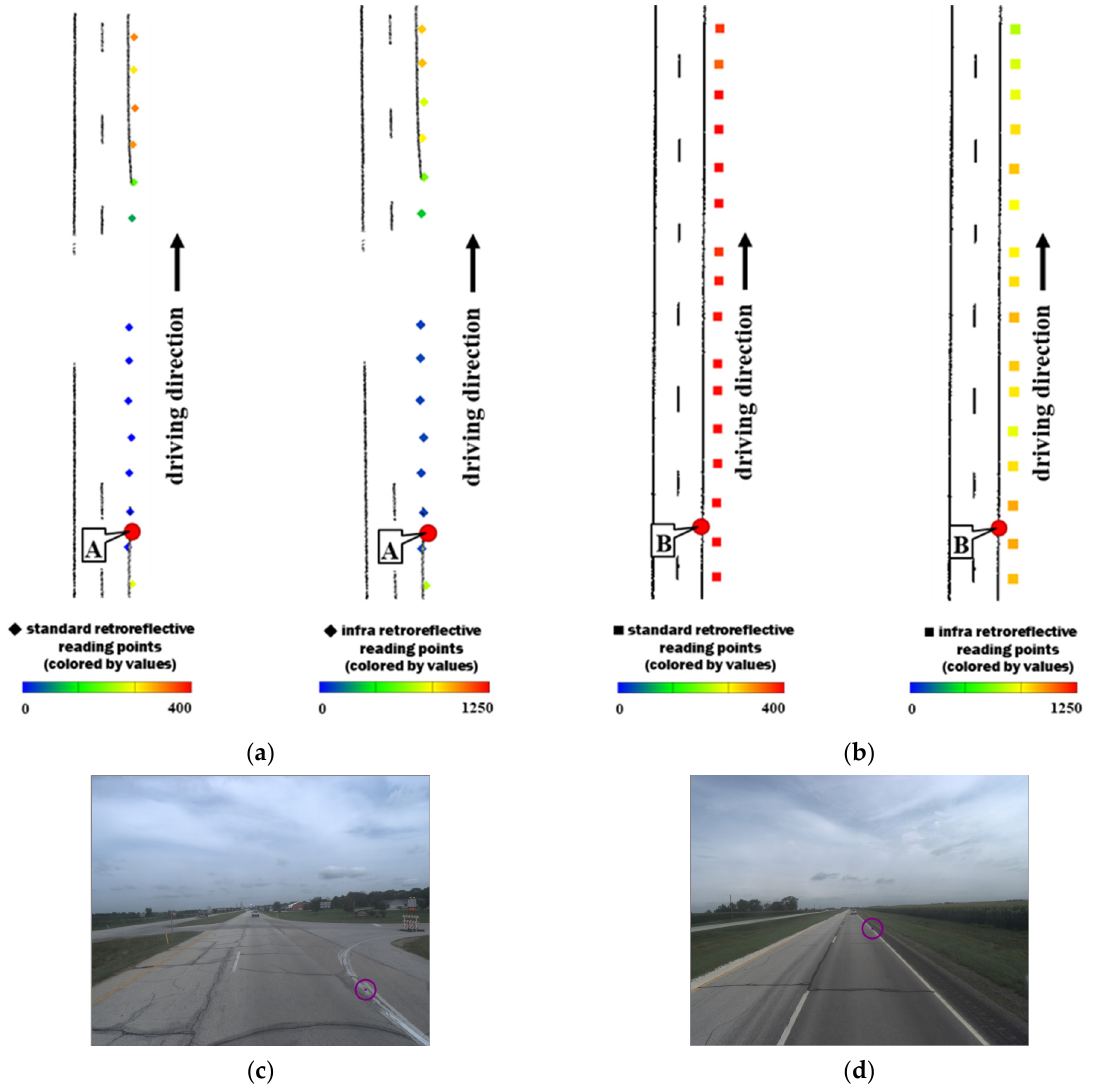
Figure 8. US-52 and 41 northbound LiDAR point clouds (colored by intensity) and retroreflective reading points: ( a ) intersection (no lane marking) area; ( b ) complete lane marking area; corresponding image for ( c ) locations A and ( d ) B.